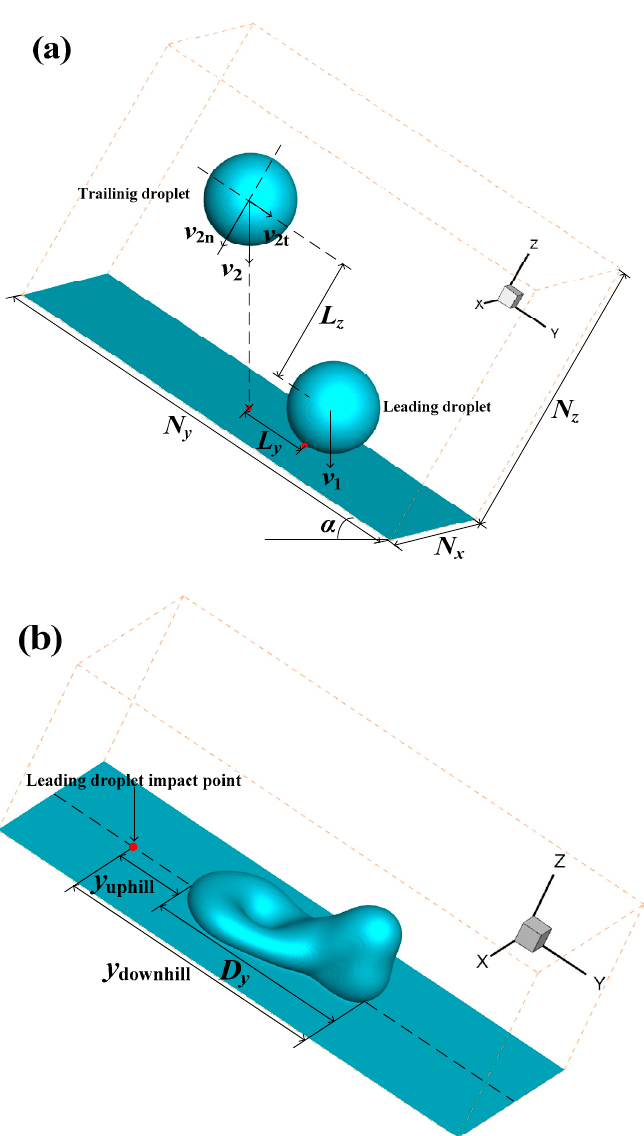
Figure 2. Schematic of two droplets impacting an inclined surface successively ( a ) The initial state of two droplets; ( b ) The morphology of two droplets during spreading and retraction